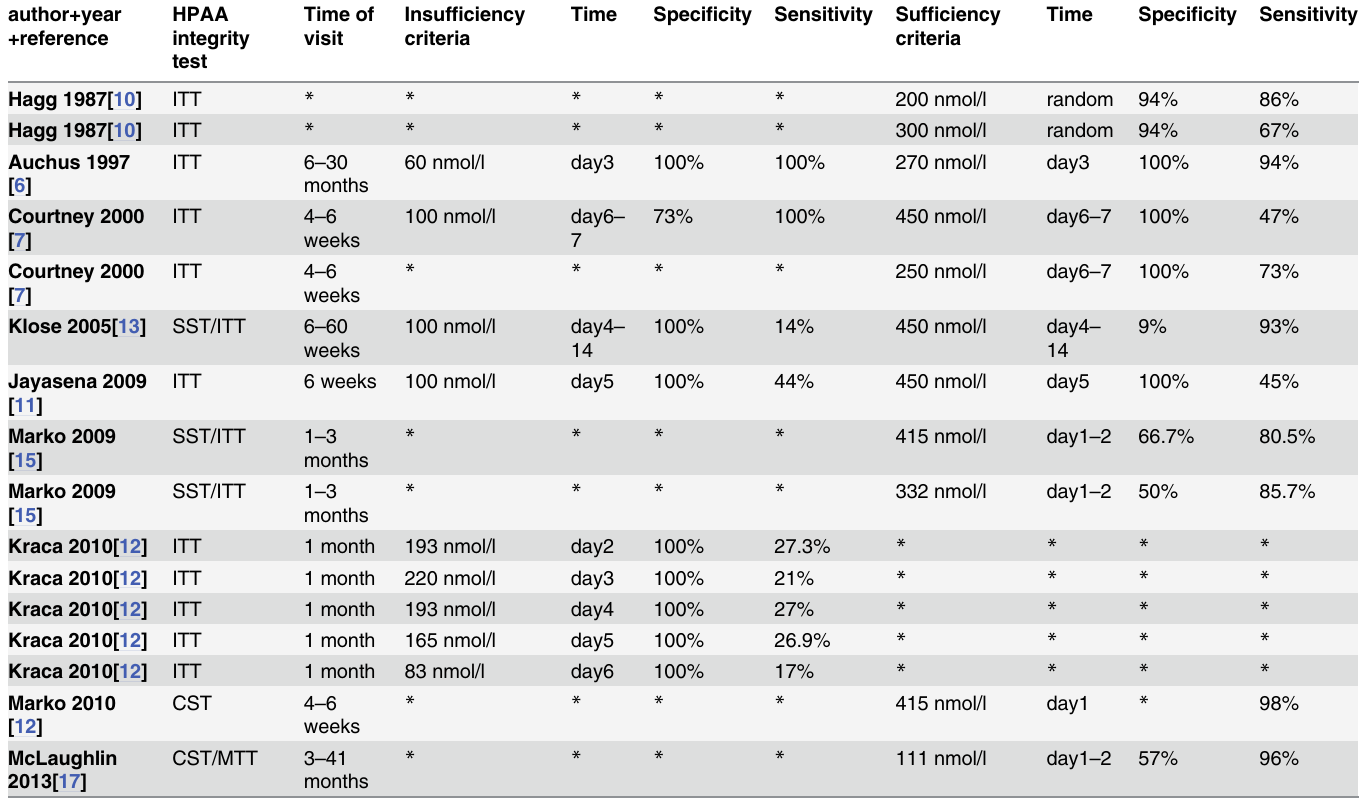
Table 3. The predictive value of early postoperative MSC levels for HPAA integrity assessment. author+year